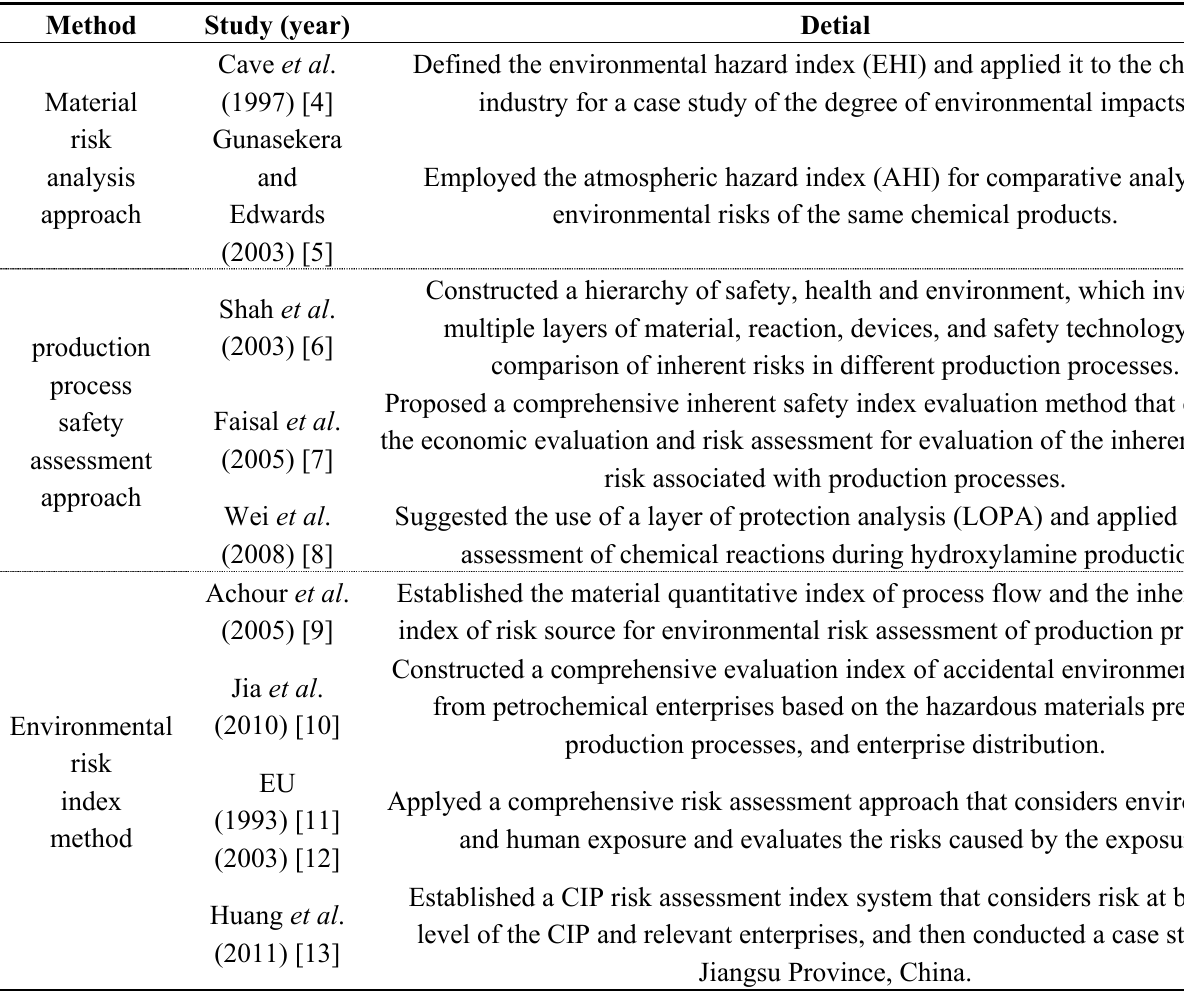
Table 1. Risk assessment method of the chemical